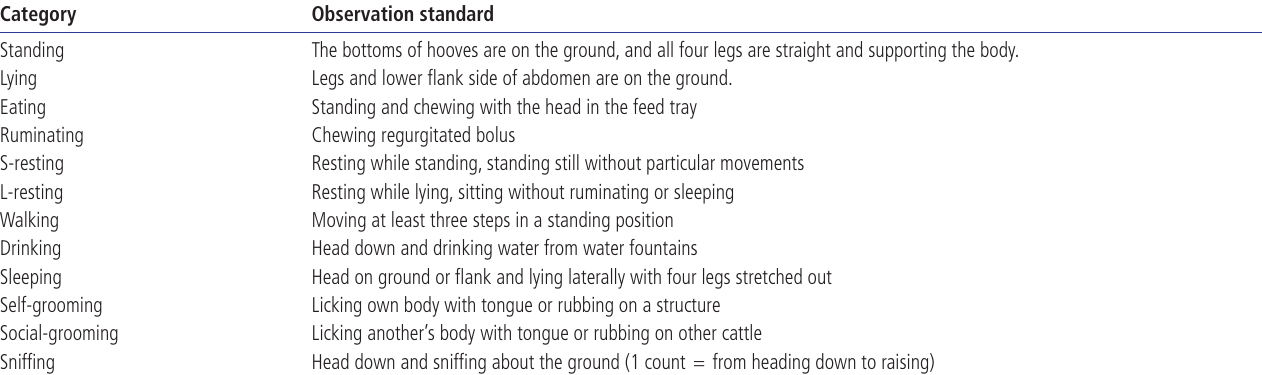
Table 3. Descriptions of recorded behavioral categories Category Observation standard Standing